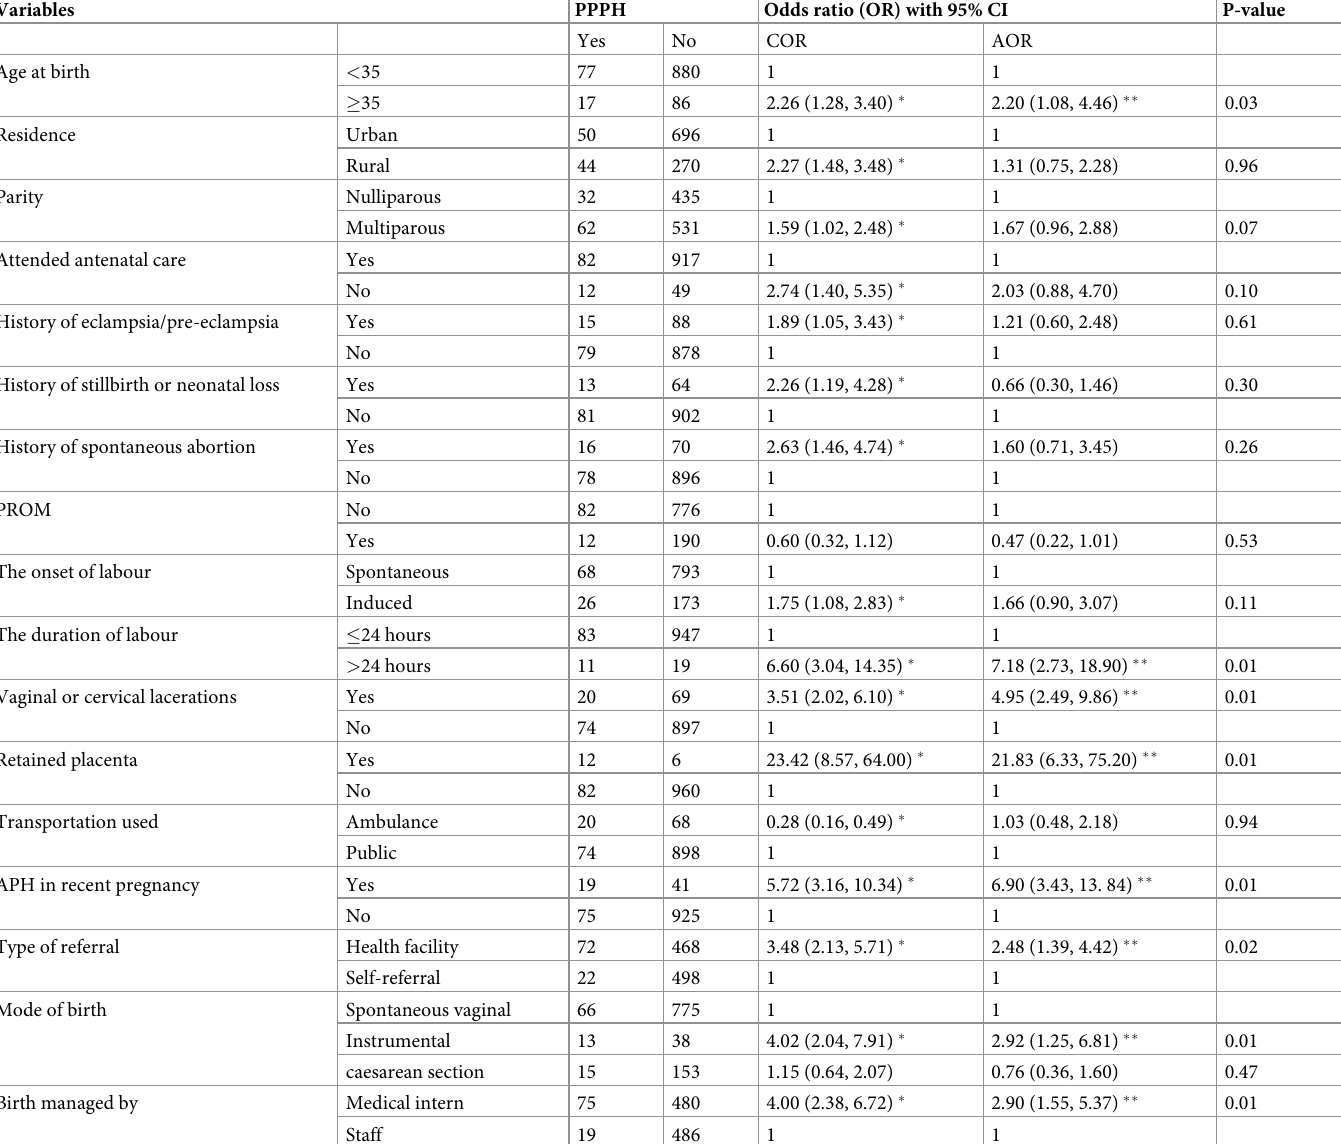
Table 2. Univariate and multivariate logistic regression analysis of factors associated with primary postpartum haemorrhage following in-hospital births, 2018 (n = 1060).